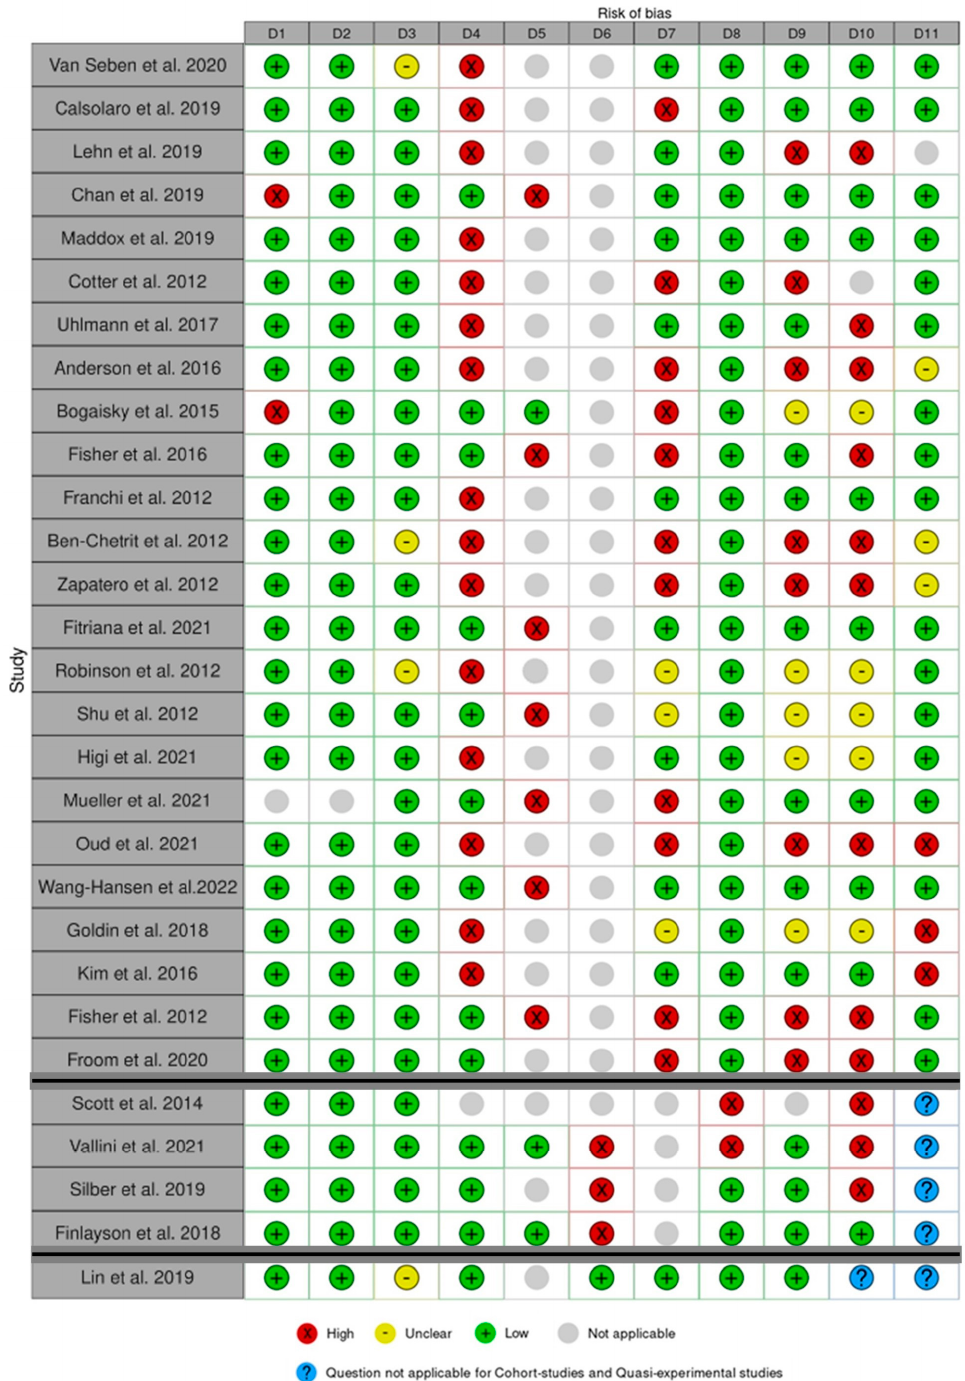
Figure 3. Quality assessment for cohort studies in the first part, case-control studies in the second part and quasi-experimental studies in the third part. The Robvis Tool ® [52] was used for this figure.